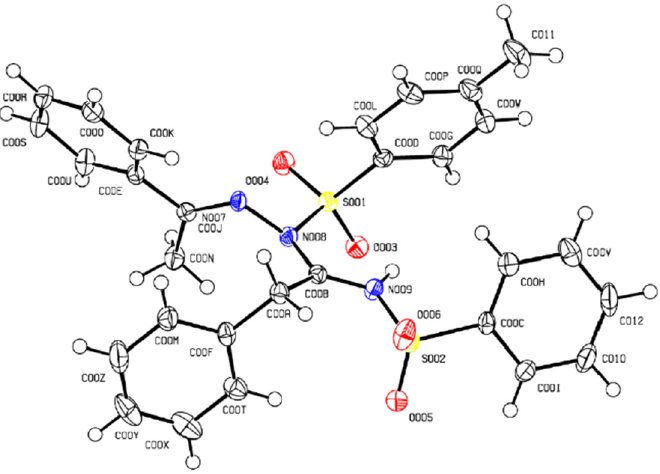
Figure 2. X-ray crystal structure of compound 4a .